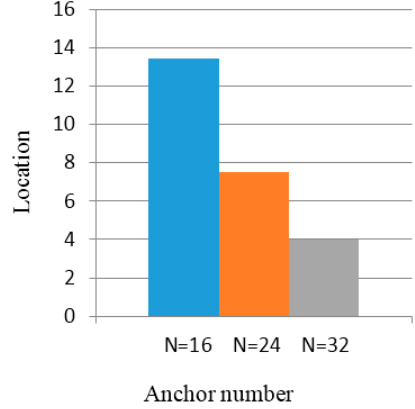
Figure 20. Location errors with intensity value fluctuation of 5%.